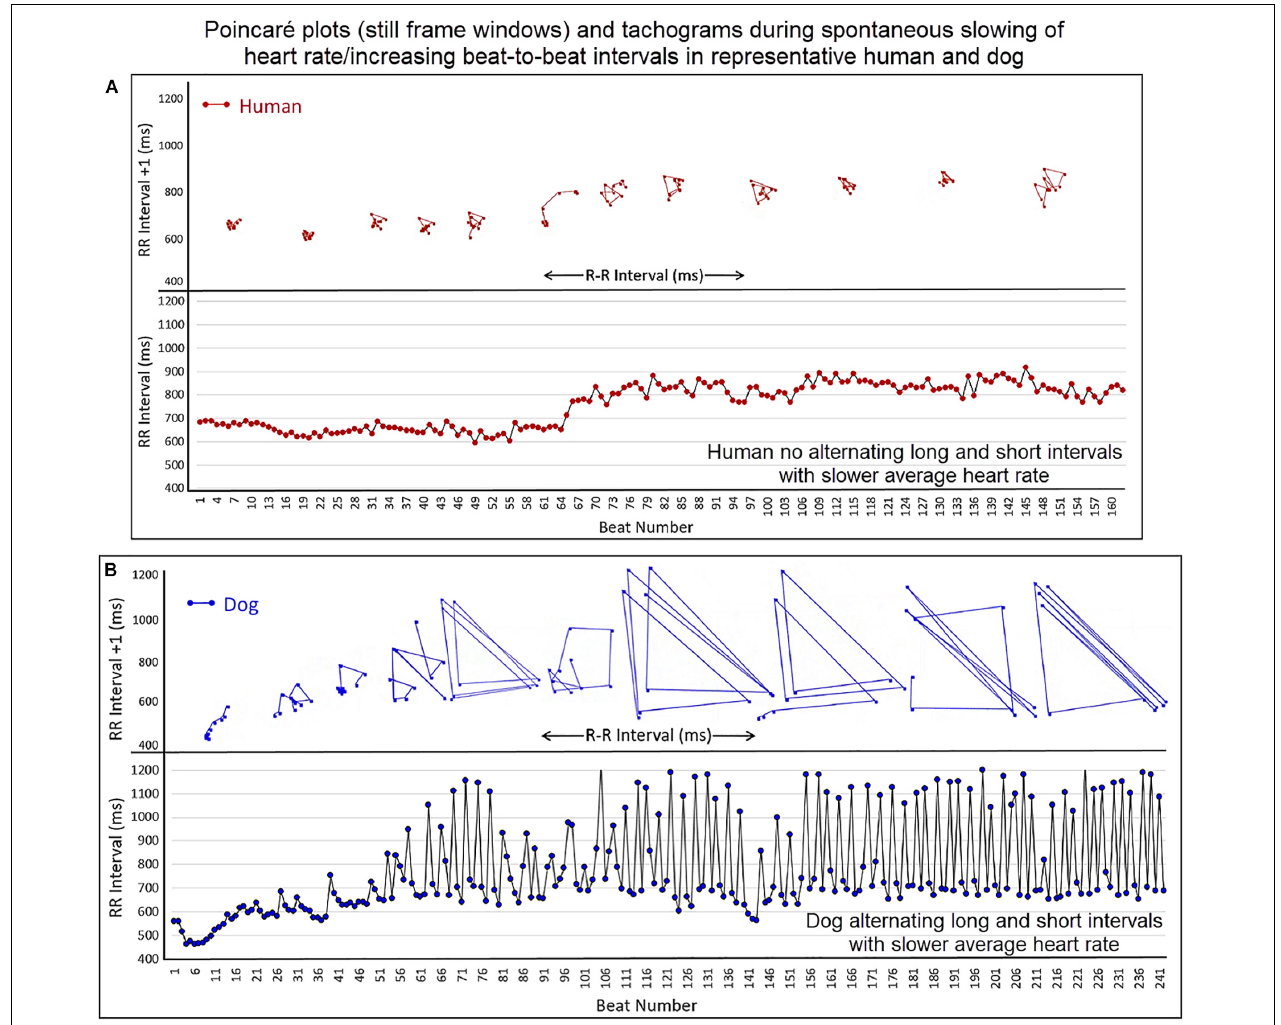
FIGURE 10 | ( Supplementary Video 7 ) This figure illustrates the slowing of the sinus rhythm in the human and dog. As the human sinus node slows the beat-to-beat variation is confined along the line of identity (Frame A ). As the dog sinus node slows (Frame B ), the rate slows along the line of identity, just as in the human, until approximately 600 ms when a bifurcation occurs with long–short R–R intervals. This is shown in the Poincaré plots as well as the tachogram in this focused illustration. For clarity, the scale for Poincaré plots on the x-axis is not shown. Supplementary Video 7 complements this